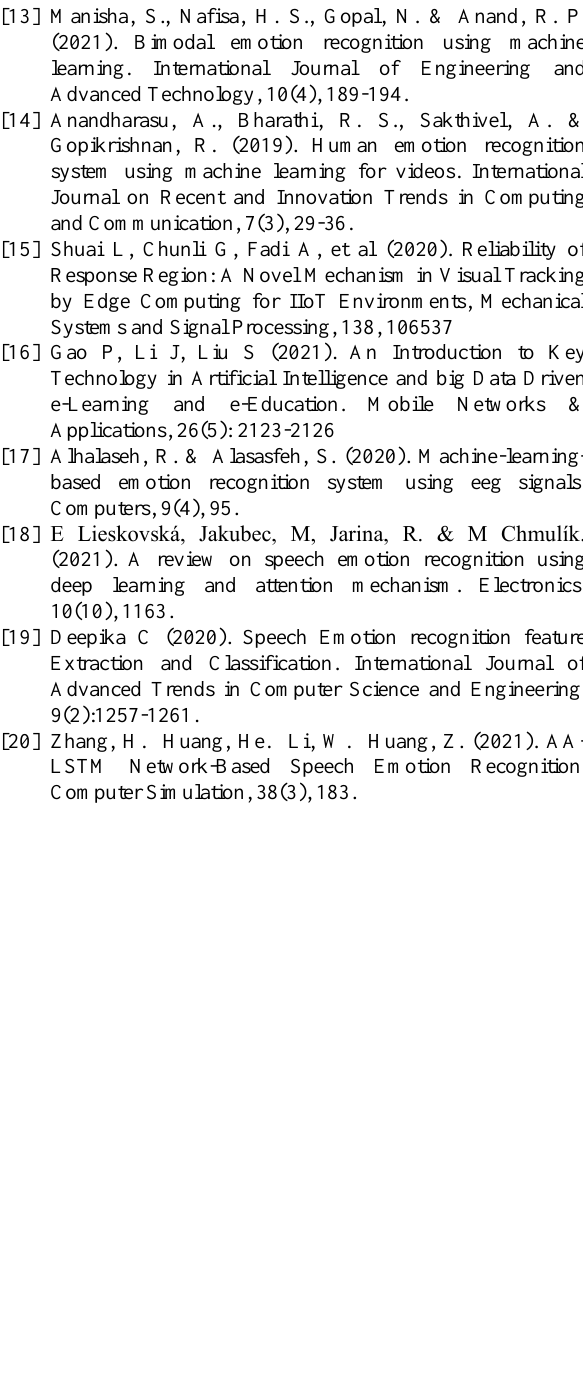
correlation analysis algorithm and support vector machine algorithm are applied to the field of speech emotion recognition in educational scenes. The